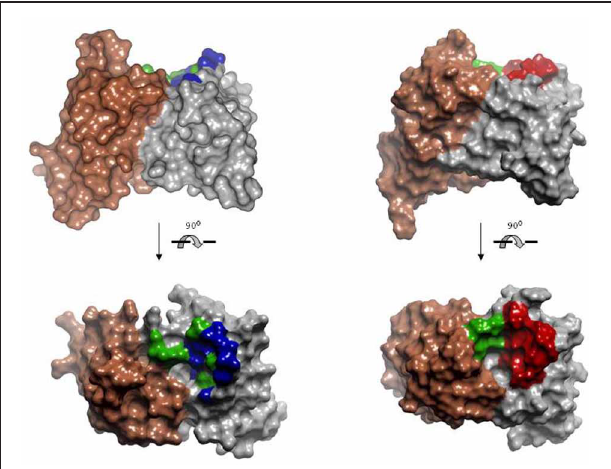
FIGURE 7 | Model of the human anti-peptide (left) and mouse anti-peptide (right) repertoires. On the top , side view of the Connolly surface of the models. Bottom , models seen from the antigen perspective. Invariant V L s are colored in brown. V H s are colored in gray. Within the antigen-binding site, green represents fully randomized positions, i.e., 20 amino acids; blue positions diversified to Tyr, Asp, Ala, and Ser; red positions diversified to incorporate the most common anti-peptide SDRs. PDBID: 1MCP and 2IGF were used as template for modeling human V L and V H , respectively. Coordinates of the antibody 26-10 (PDBID 1IGI) were used for modeling the mouse anti-peptide repertoire. The models and Figures were created in Discovery